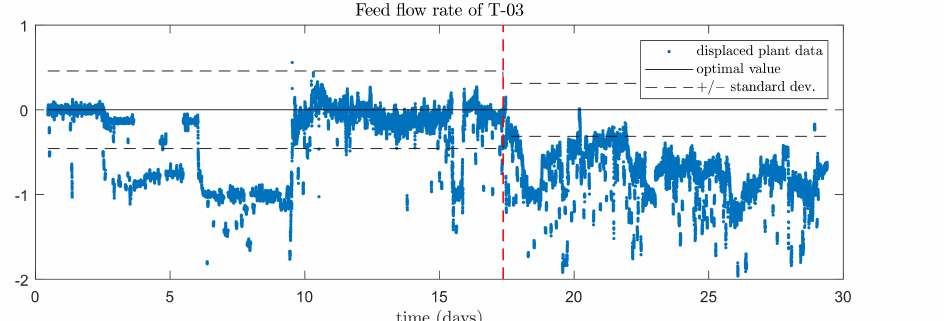
Figure 13. Optimization results: recirculation flow rate of T-03 deviated from the optimal value before and after the RTO loop closing.